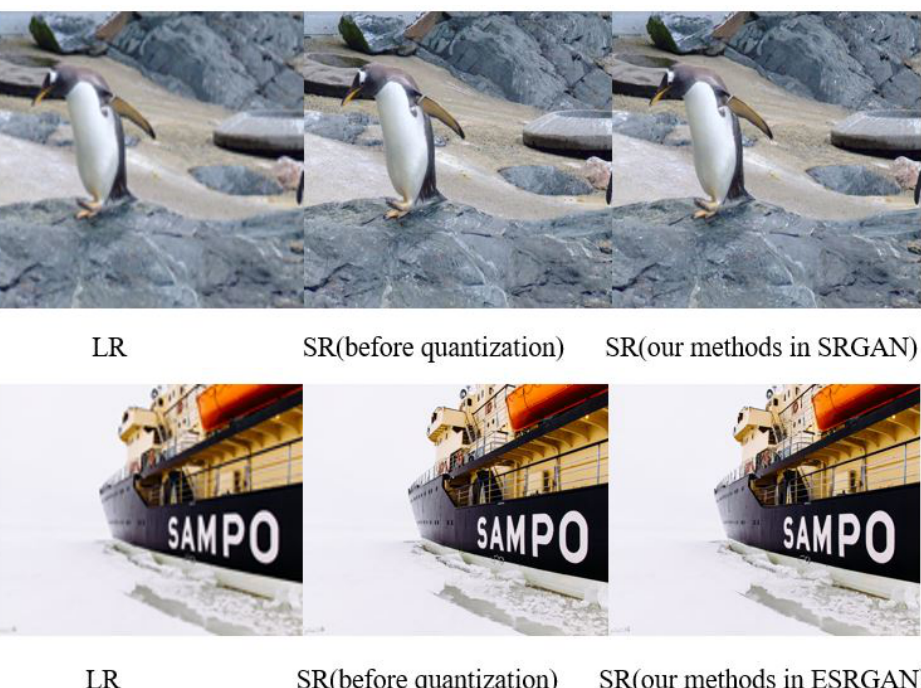
Figure 8. Two comparison of our method and the original one.